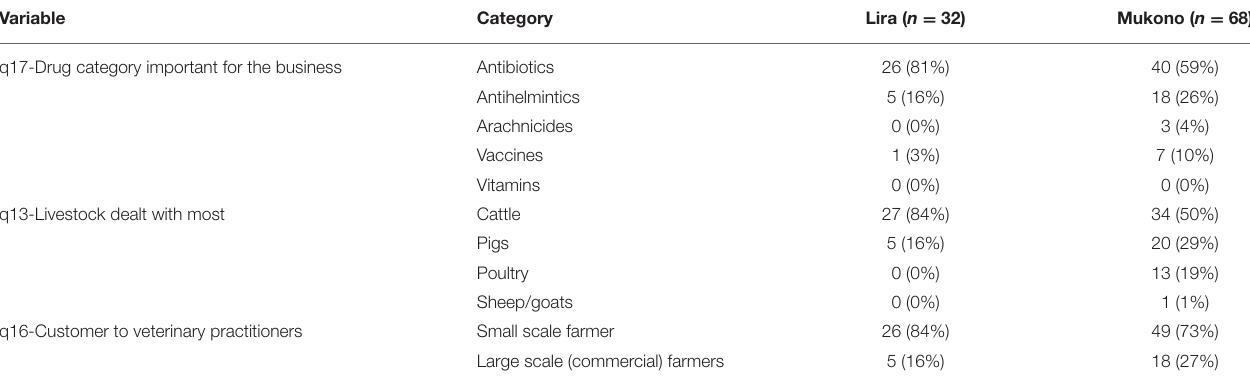
TABLE 5 | Characteristics of business delivered to farmers by veterinary practitioners.